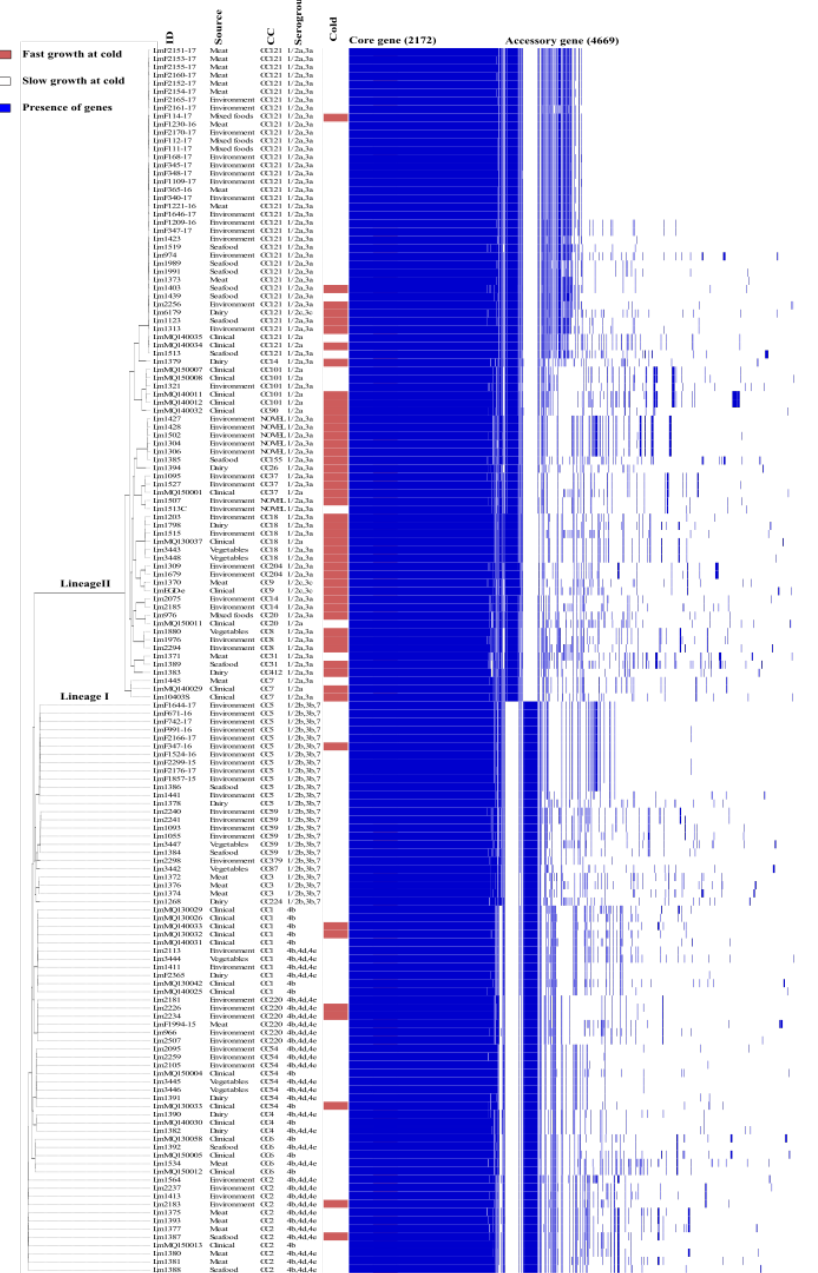
Figure 2. Alignment of MLST classification of 150 L. monocytogenes isolates with a pan-genome matrix of core and accessory genes (presence indicated by blue bars). Isolate cold growth profile (cold) is also indicated by red (fast) and purple (white) bars along with the source of the isolates.